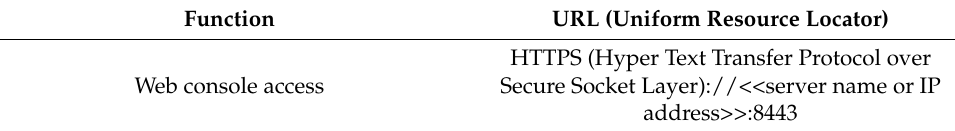
Table 8. Server communication